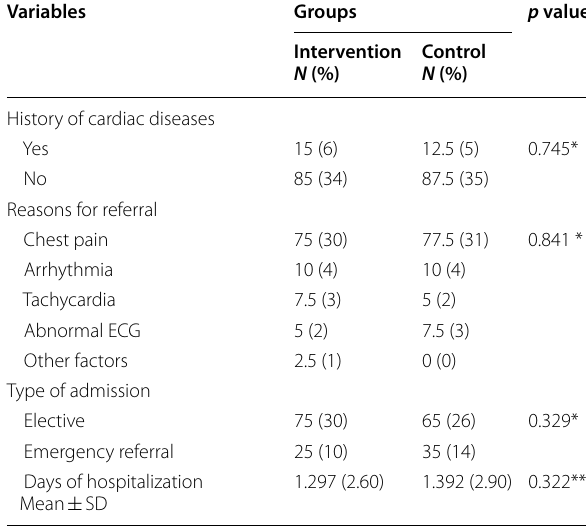
Table 1 The demographic characteristics of the participants in Table 2 The clinical characteristics of the participants in the study